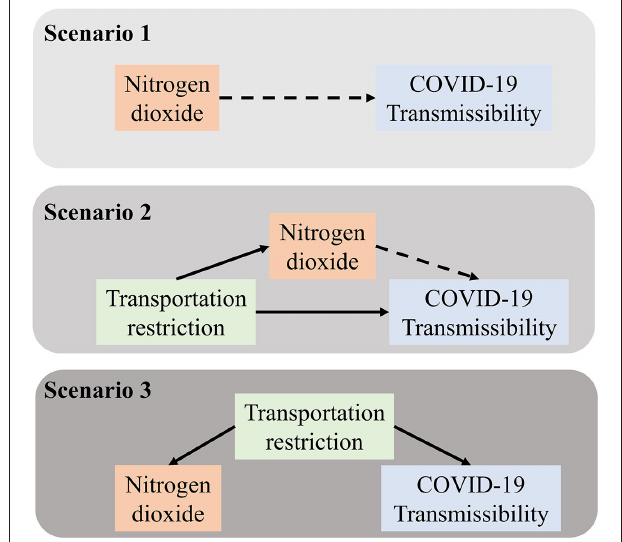
FIGURE 1 | Directed acyclic graphs of Scenario 1, Scenario 2, and Scenario 3. Scenario 1 shows the possible association between NO 2 and COVID-19 transmissibility; Scenario 2 shows the direct association between transportation restriction and COVID-19 transmissibility as well as the indirect association mediated by NO 2 ; and Scenario 3 shows that the possible confounding of transportation restriction on the association between NO 2 and COVID-19